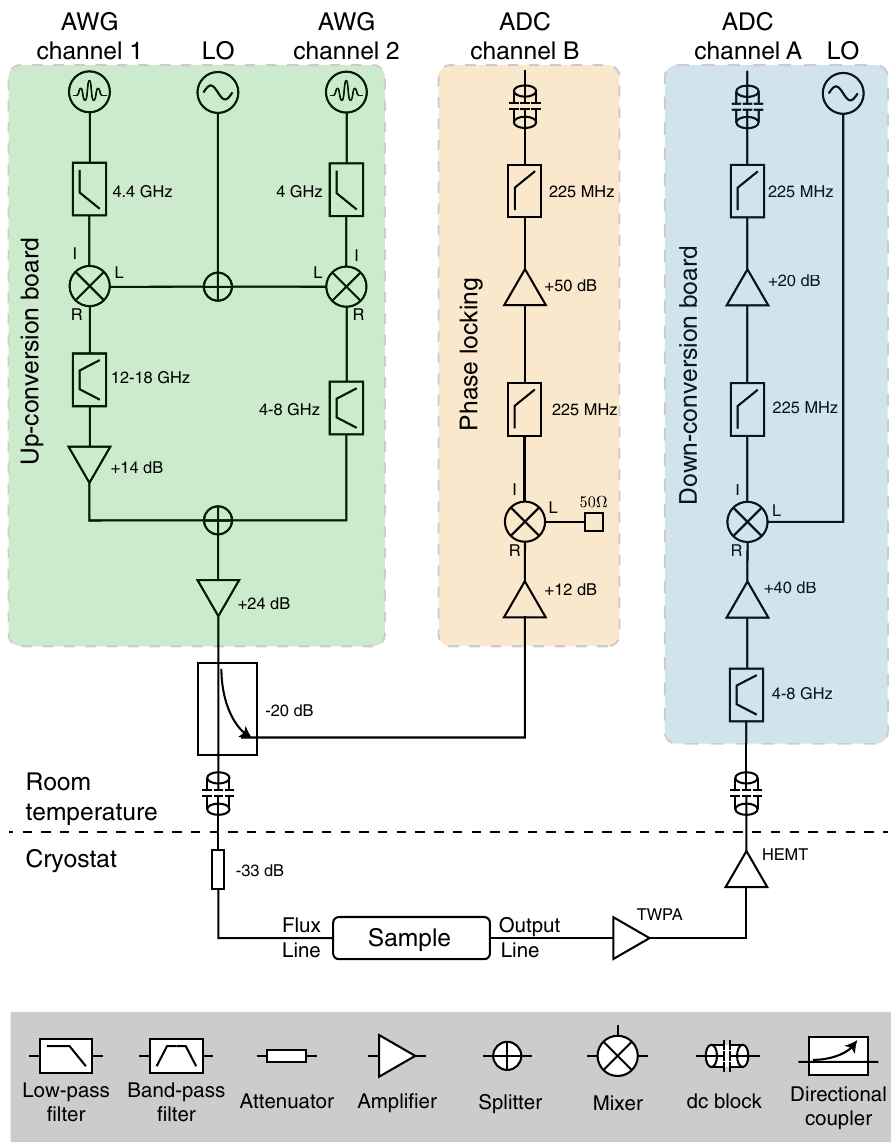
FIG. 6. Schematic diagram of the experimental